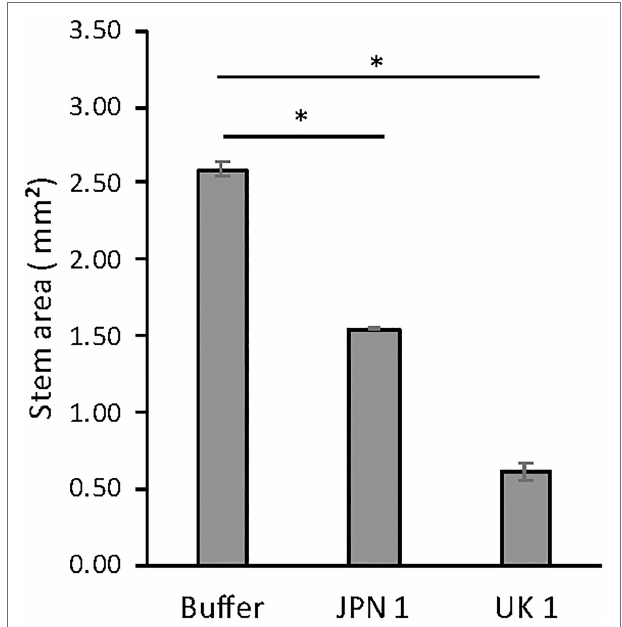
FIGURE 1 | Inflorescence stem areas of non-infected and TuMV-infected Arabidopsis plants, showing statistically significant differences (marked with and asterisk) between infected and non-infected plants (see text for experimental details). The statistical analysis was a student’s t -test comparing Mock and JPN 1, and Mock and UK 1 ( p <